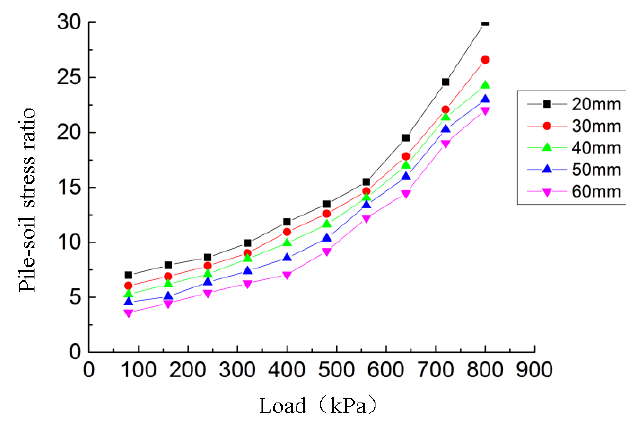
Figure 19. The thickness of the cushion effect on the pile-soil ratio.